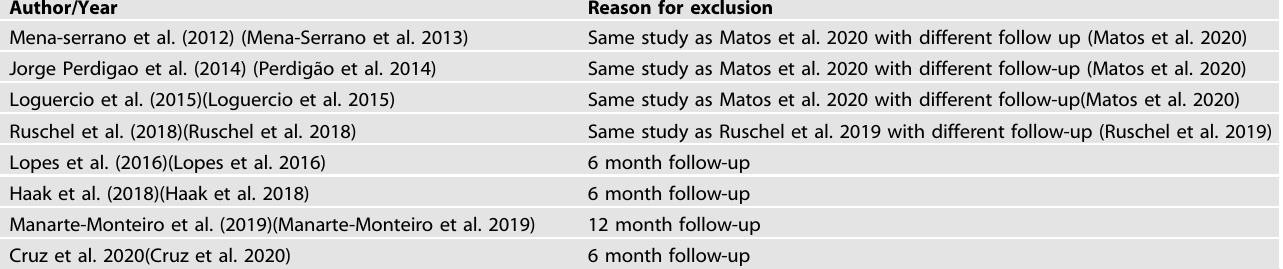
Table 2. List of excluded studies with reasons.